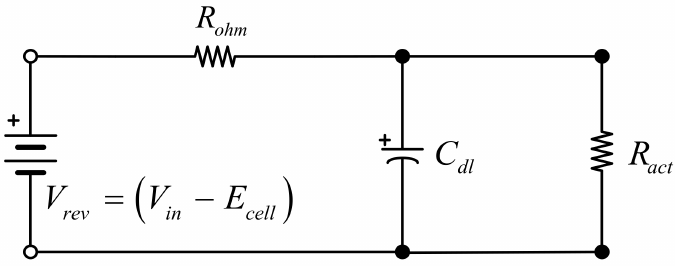
Figure 4. Equivalent circuit of water electrolysis load.